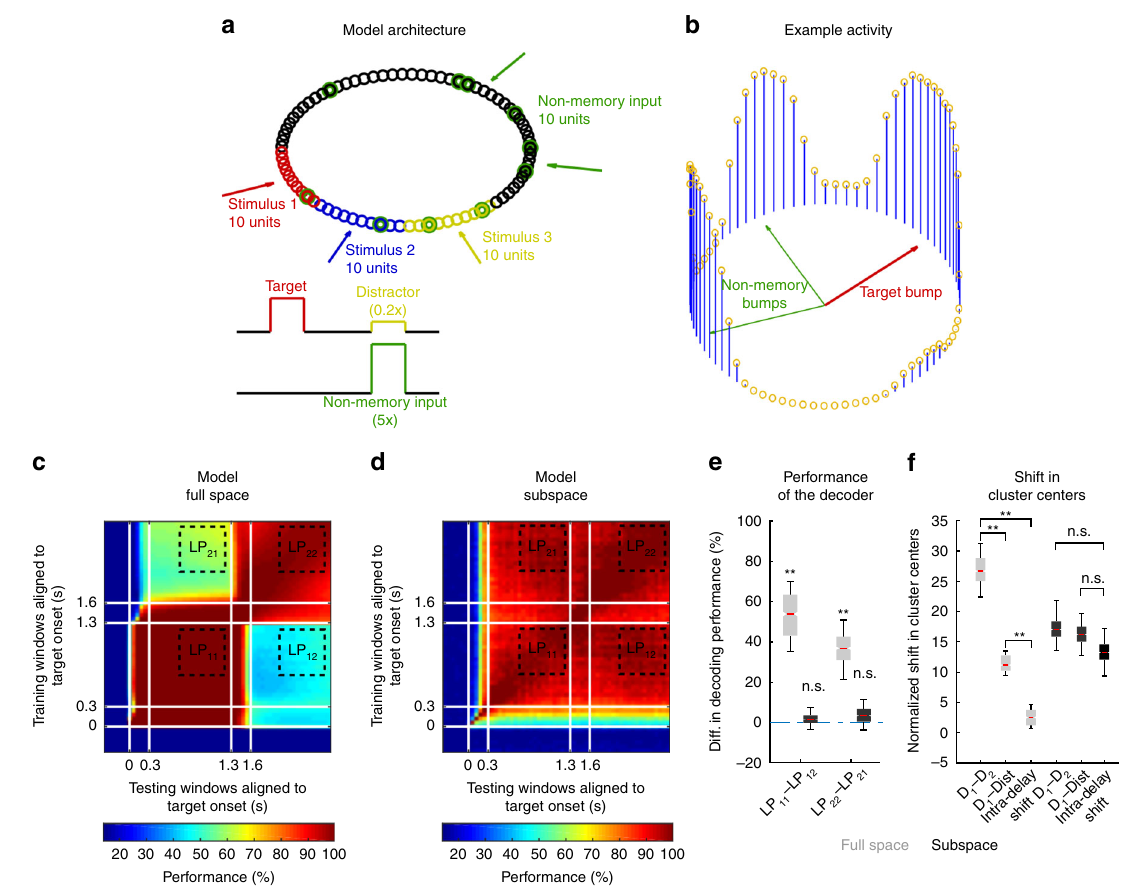
Fig. 5 Model of code-morphing in prefrontal cortex. a Bump attractor model (adapted from Wimmer et al. 17 ) with eight location inputs representing the eight location stimuli for target or distractor, and a non-memory input that was active during the distractor presentation period. The recurrent layer contained 80 units, and each location input projected onto 10 adjacent units that were non-overlapping for different locations (red, blue, and yellow units). The non-memory input projected onto 10 random units in the population (green units), which overlapped with different location units. b An example of the activity found in the recurrent layer in Delay 2 after the distractor was presented. c Heat map showing the cross-temporal population-decoding performance of the model in the full space. d Heat map showing the cross-temporal population-decoding result of the model after projecting into the subspace. e The differences in decoding performance ( LP 11 − LP 12 , LP 22 − LP 21 ) in the model in the full space are shown in gray box-plots. The equivalent performance differences in the subspace are shown in the black box-plots. f The normalized shift in cluster centers averaged across target locations (D 1 – D 2 , D 1 — Dist, and intra-delay) in the model are shown in the full space (gray box-plot), and in the subspace (black box-plot). The bounds in the boxplots are de fi ned by the 25th and 75th percentile of the distribution. The red line represents the median and the whiskers represent the 2.5th and